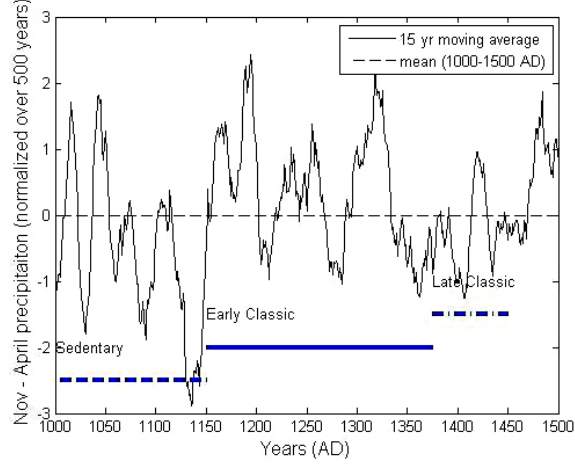
Fig. 14. A proxy for runoff conditions in the Hohokam. Ob- tained by subtracting reconstructed and standardized annual mean- maximum temperature from the reconstructed and standardized Oc- tober through July precipitation for the southern Colorado Plateau. The standardization is for the period between AD1000 to 1500. Compiled from Salzer and Kipfmueller